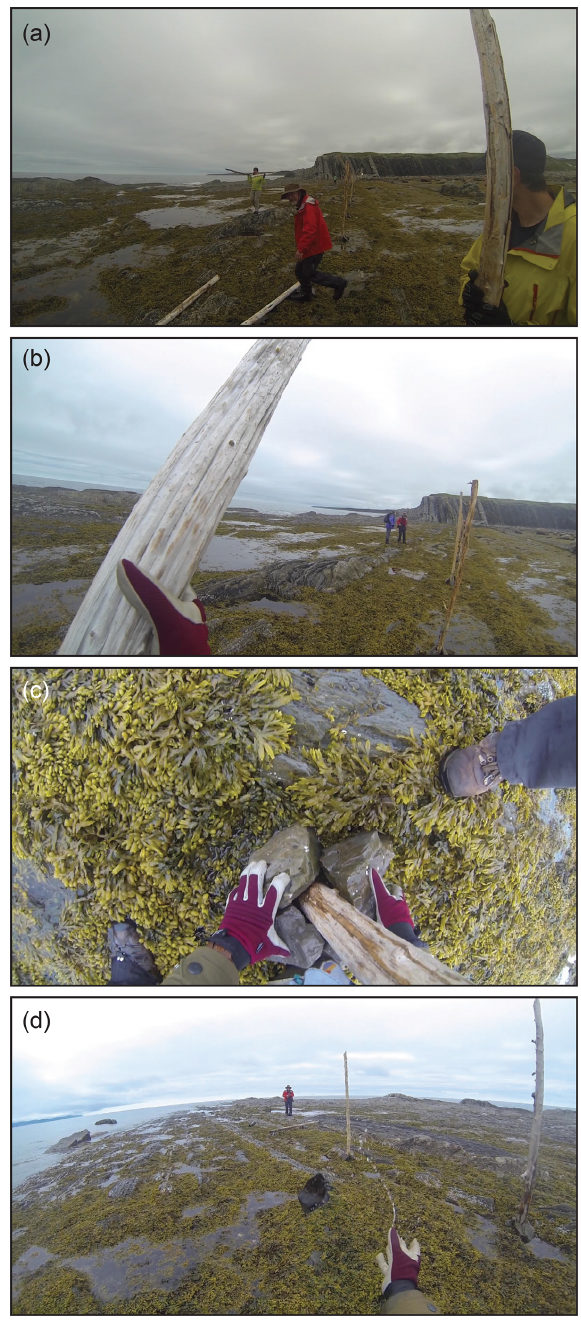
Figure 6. (a–d) Still images from GoPro™ – first author’s head- mounted camera – taken during the installation process.